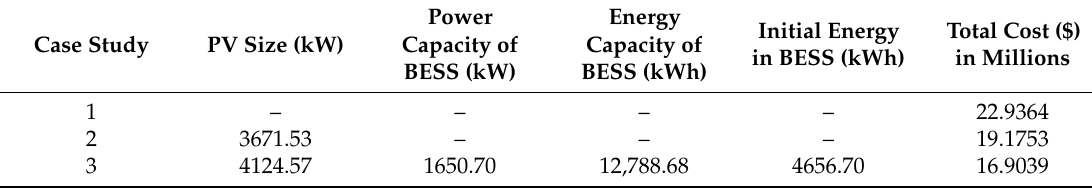
Table 7. Summary of optimal energy storage and PV sizes for case studies, a stochastic approach.